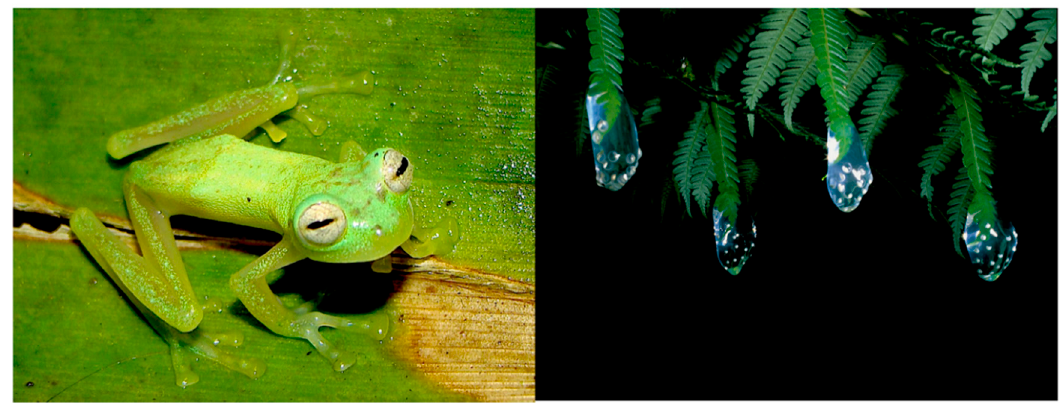
Figure 187. Nymphargus wileyi in life. ( Left ): Adult male from Yanayacu Biological Station, Napo province, QCAZ 37972. ( Right ): Egg clutches of N . wileyi at Yanayacu Biological Station. Photos by Martín Bustamante.